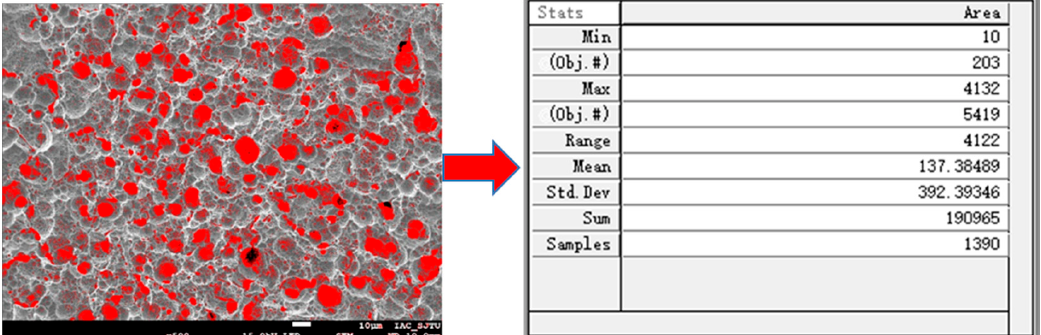
Figure 2. Statistics of porosity using Image-Pro Plus software.